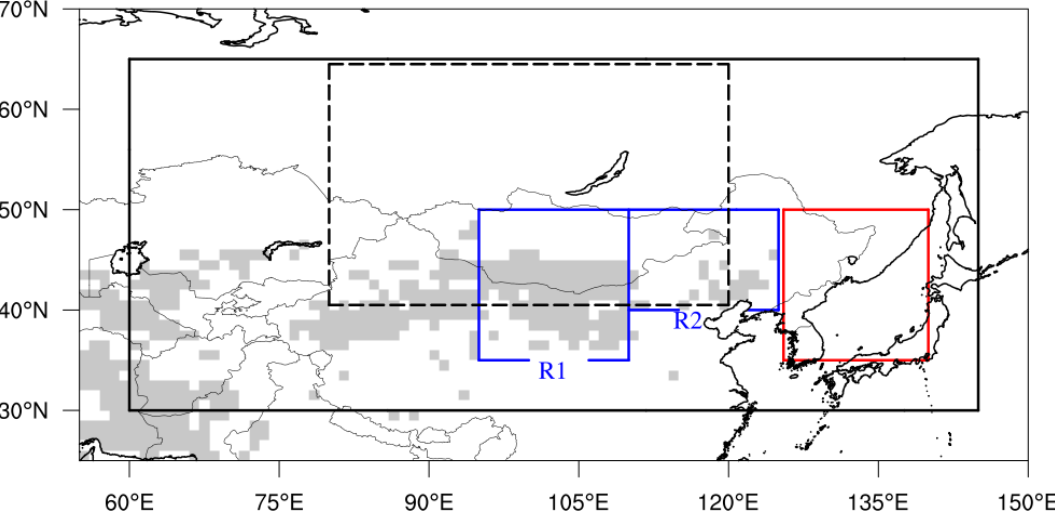
Figure 1. Research domain in this study. The black solid line represents the area for calculating the SHPI. The black dashed line represents the area for calculating the SHI. The two blue solid lines (R1 and R2) denote dust source regions. The red box is the ETC domain. The grey shaded area denotes the dust area. We used the fractional dust source inventory data of 1° × 1° resolution from https://www.gfdl.noaa.gov/atmospheric-physics-and-chemistry_data/ [69].